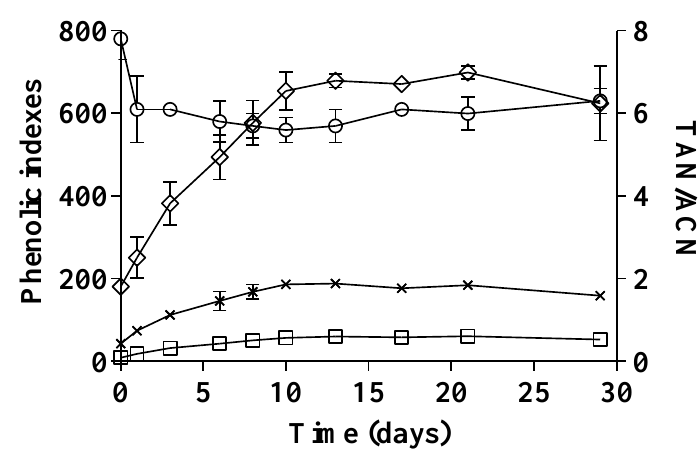
Figure 2. Time course of extraction of phenolic compounds during fermentative maceration of Sangiovese red grapes. Error bars below 5% CV are omitted to improve the quality of the plot. Legend: ( (cid:3) ) IPT; ( × ) EasyOx, ( ♦ ) PhenOx; ( ○ ) TAN/ACN.